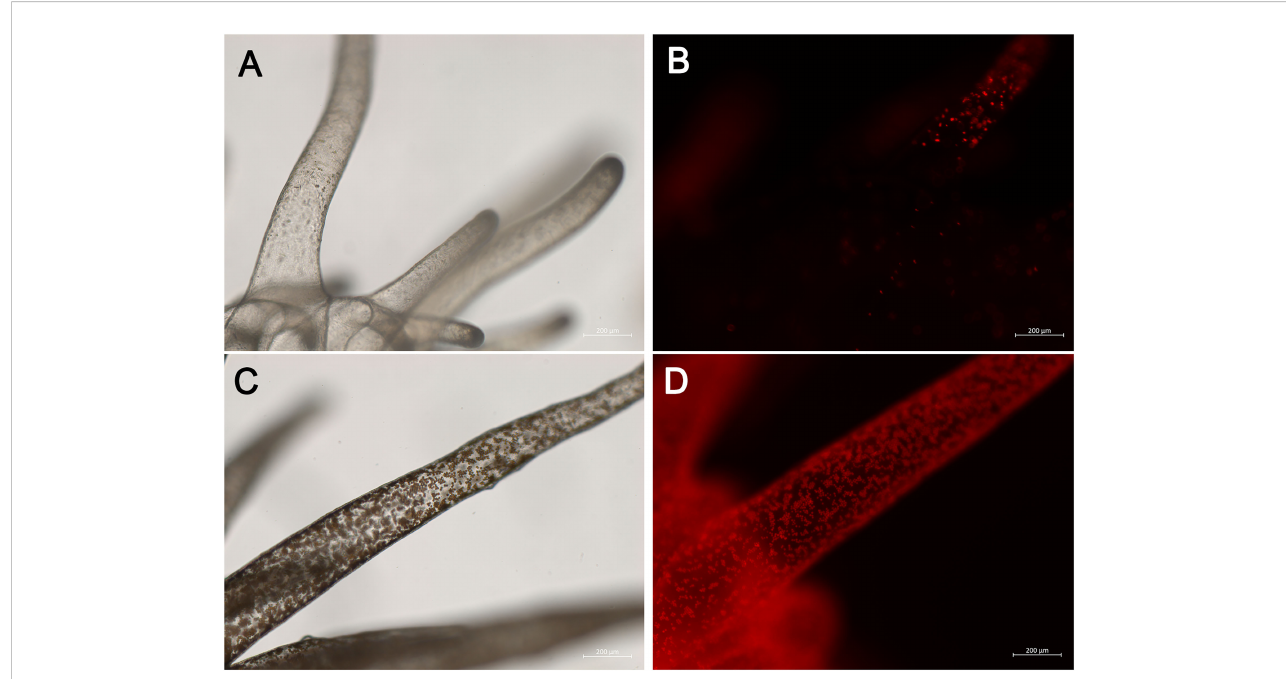
FIGURE 1 Images of sea anemone E. diaphana demonstrating symbiont-depleted (A, B) and symbiont-rich (C, D) states. Images acquired using the Zeiss Axio Imager M2 Light Microscope under bright fi eld (A, C) or fl uorescent light (B, D) and Zeiss Zen Image Acquisition and Processing